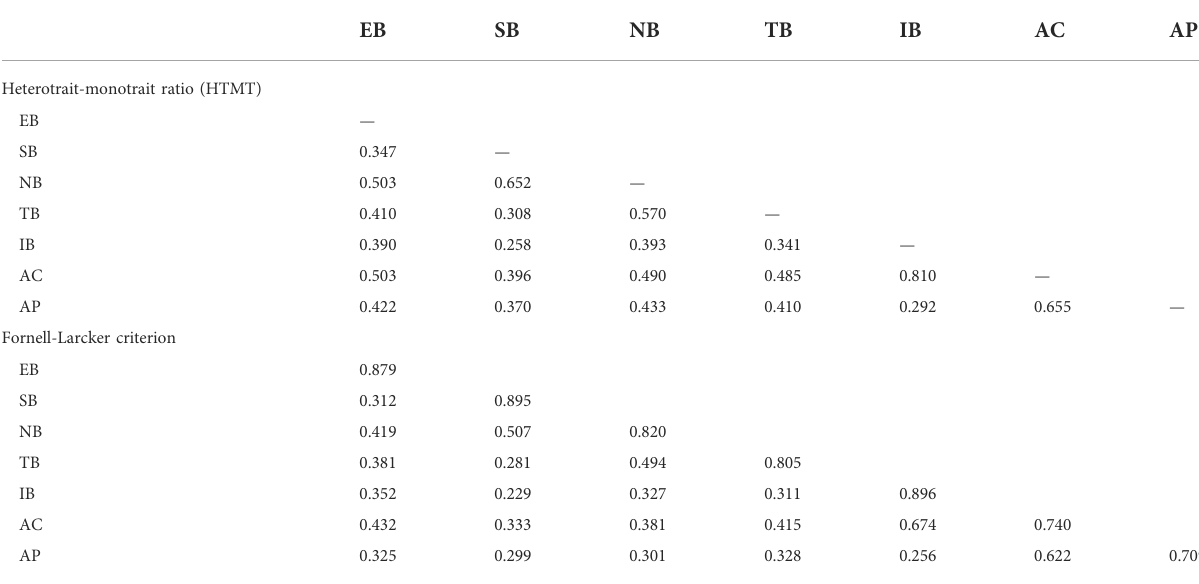
TABLE 3 Discriminant